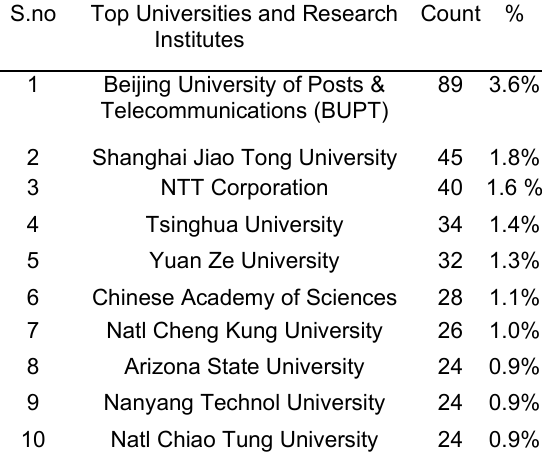
Table 7. Top Universities and Research